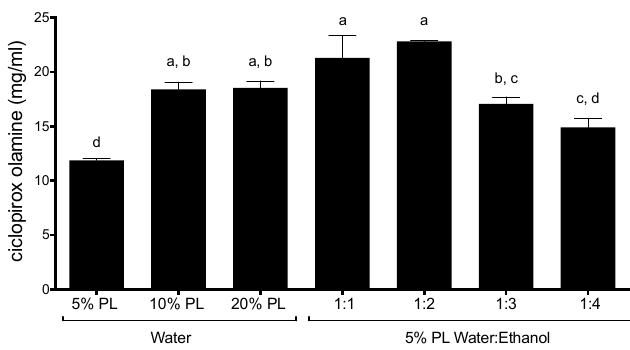
Figure 5. Solubility (mean ± SD, n = 6) of ciclopirox olamine in different aqueous lacquer bases made with different proportions of Poloxamer 407 and in hydroalcoholic lacquers made with different proportions of ethanol and with 5% Pluronic ® F127. Same letter indicates homogeneous groups (one-way ANOVA, Tukey post-hoc test, α < 0.05).